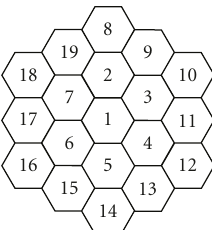
Figure 3: Cellular network consisting of nineteen cells with wrap- around structure.